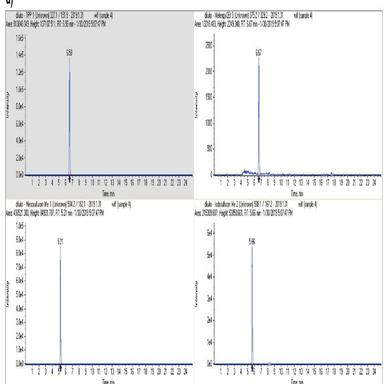
OD formulation: Mesosulfuron-methyl, Mefenpir-diethyl and Iodosulfuron-methyl-sodium by LC-MS/MS in pristine form a) and 1st fraction eluted by AF4- FFF-MALS b).